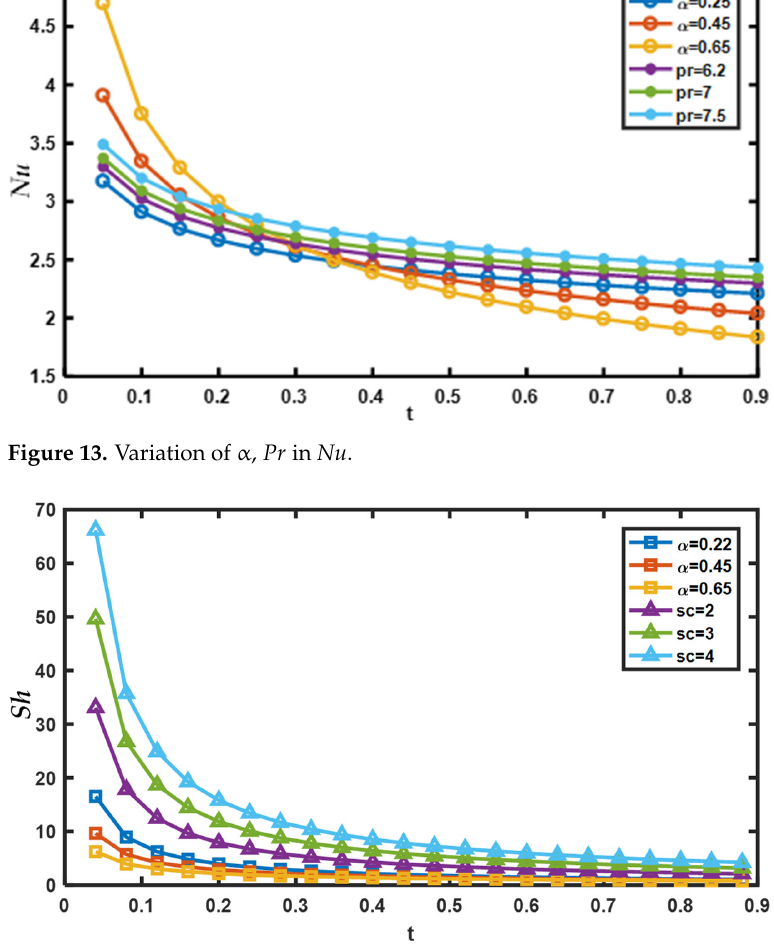
 , sc in sh . Figure 14. Variation of α , sc in sh